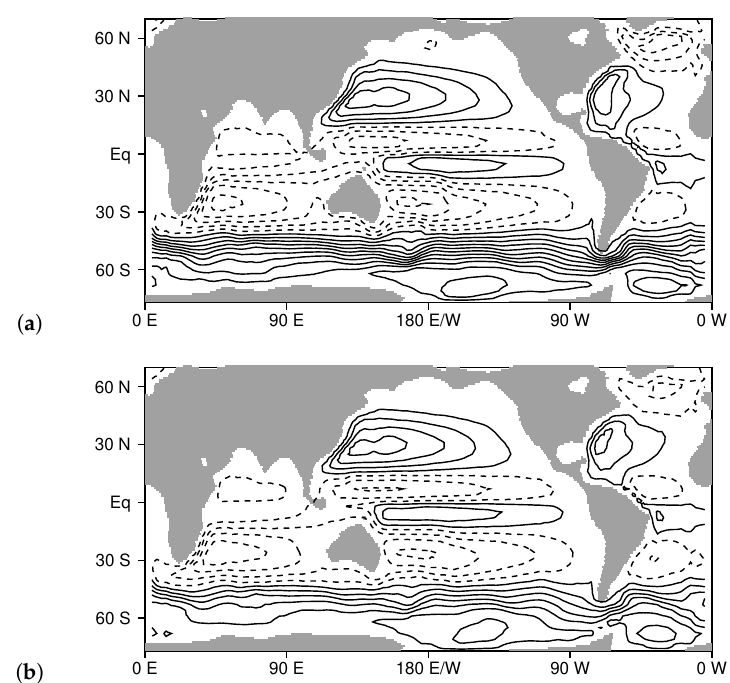
Figure 6. Horizontal streamfunction (10 Sv contour interval). ( a ) Simulation with interior mixing. ( b ) Simulation without interior mixing. Positive (negative) contours are drawn with solid (dashed) lines, with contour values ranging from − 45 to 105